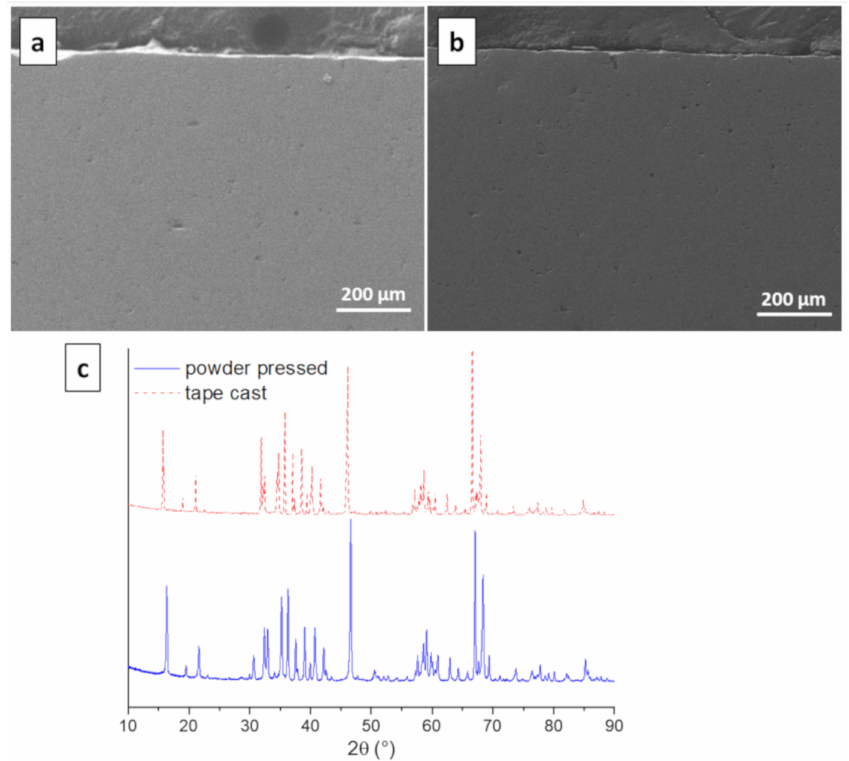
Figure 5. SEM of Na- β ”-Al 2 O 3 ceramics prepared by uniaxial powder pressing and sintering ( a ) and by tape casting and sintering ( b ). XRD of both ( c